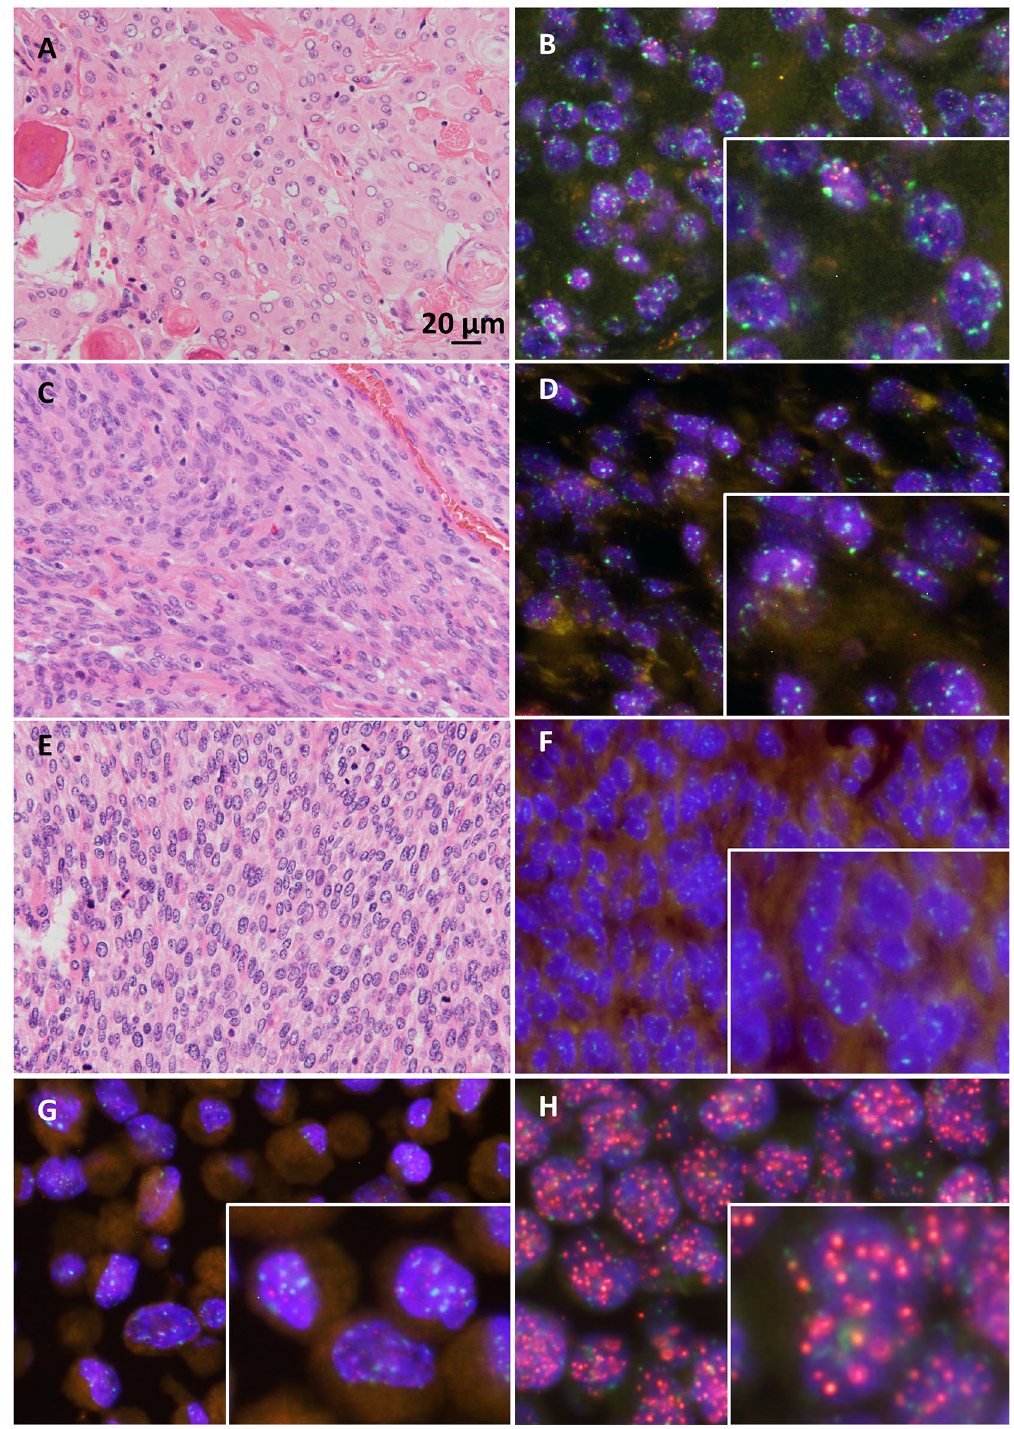
Figure 1. Meningioma cases. ( A , B ) WHO grade I; ( C , D ) grade II; ( E , F ) grade III. ( G ) HFL-1, internal control cells for FISH analysis; ( H ) 1301 cells with long telomeres. ( A , C , E ) H&E, original magnification × 400; ( B , D , F – H ) FISH images; red, telomere; green, centromere; blue, DAPI; original magnification × 800. H&E hematoxylin–eosin; FISH fluorescence in situ hybridization, WHO World Health